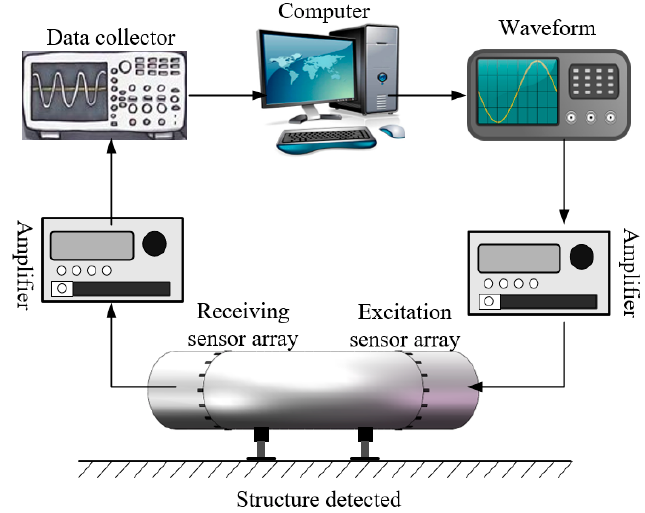
Figure 8. The diagram of ultrasonic guided wave detection scheme.